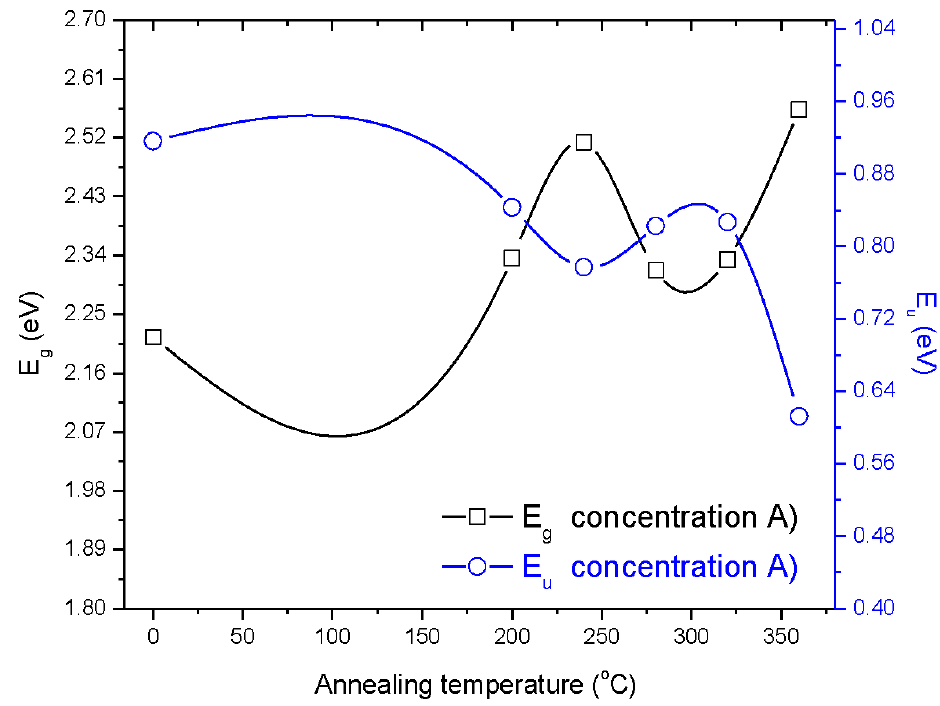
Figure 9. Variation of the optical energy band gap ( E annealing temperature for concentration A.